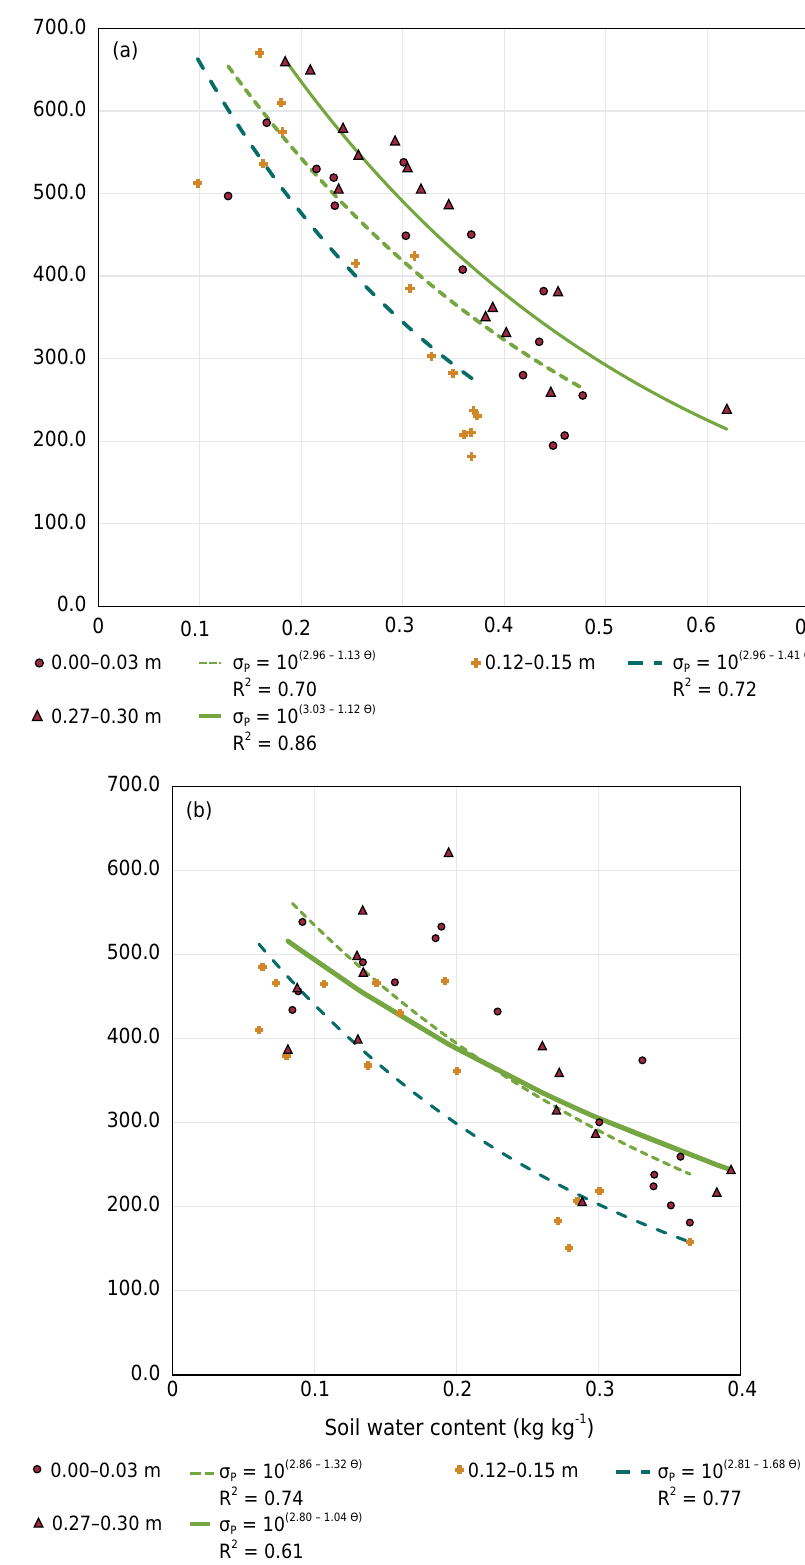
6 Rev Bras Cienc Solo 2022;46:e0220051